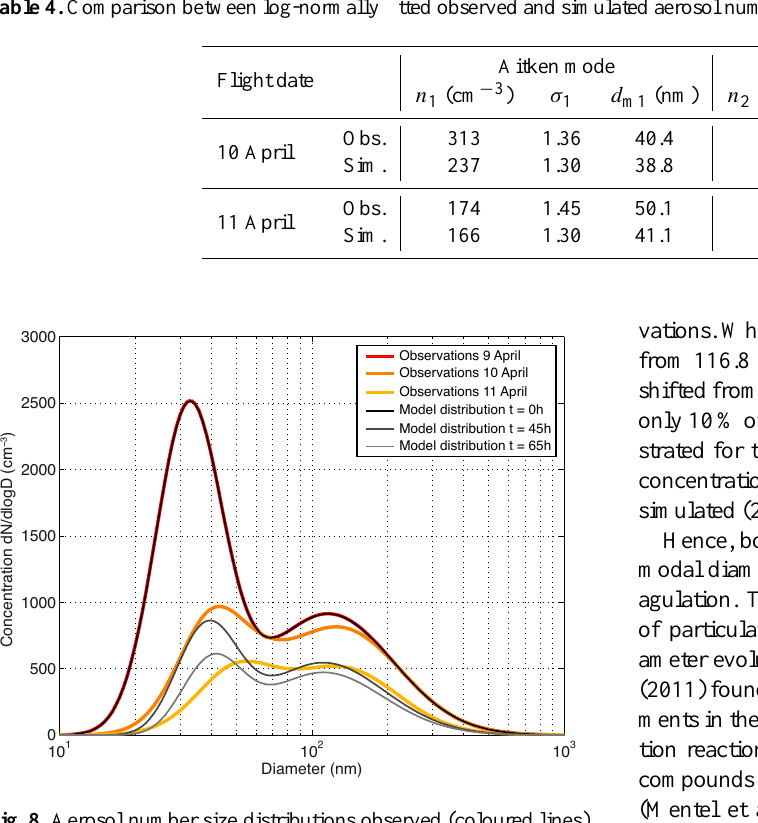
Table 4. Comparison between log-normally fitted observed and simulated aerosol number size distribution parameters.